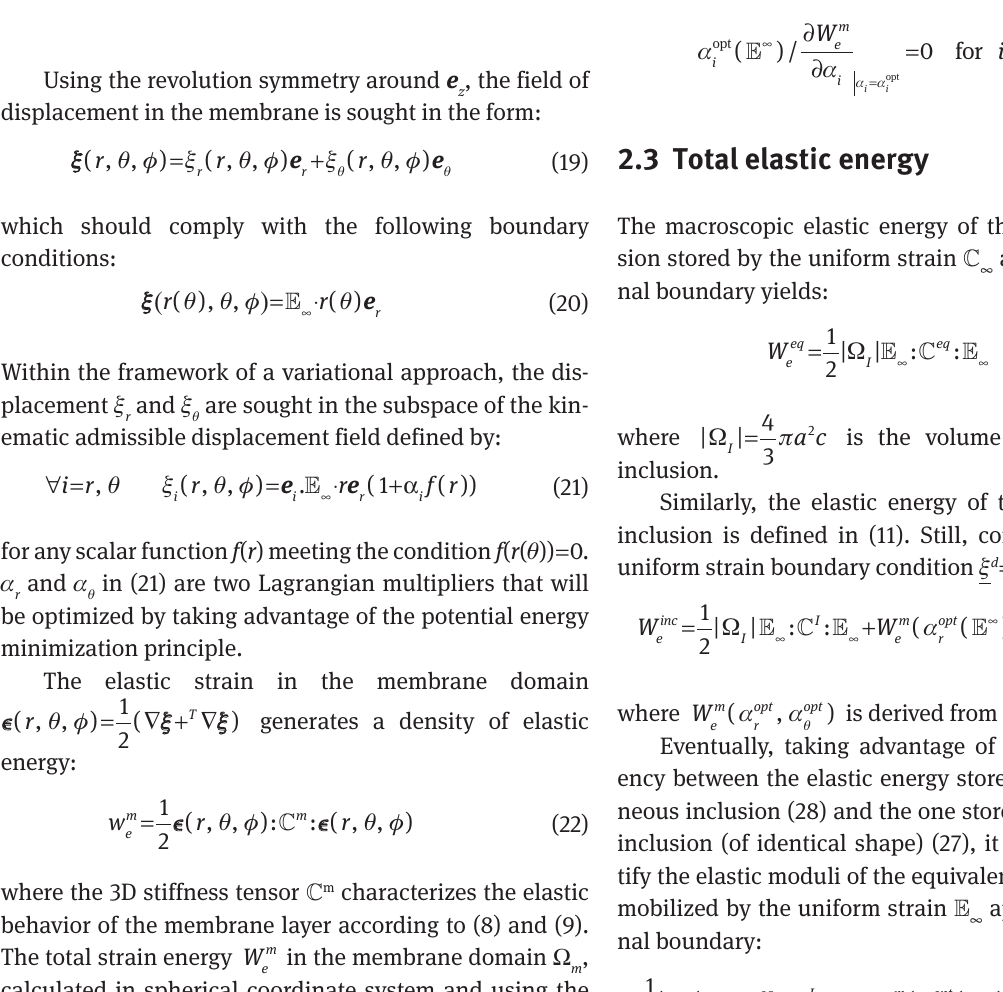
Figure 2 Equivalent inclusion